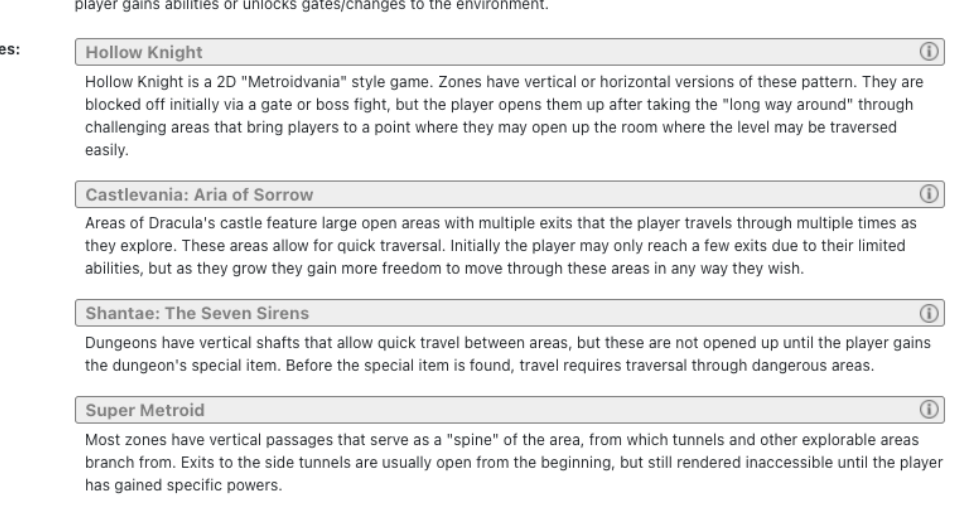
Figure 1. Example designer-created pattern.